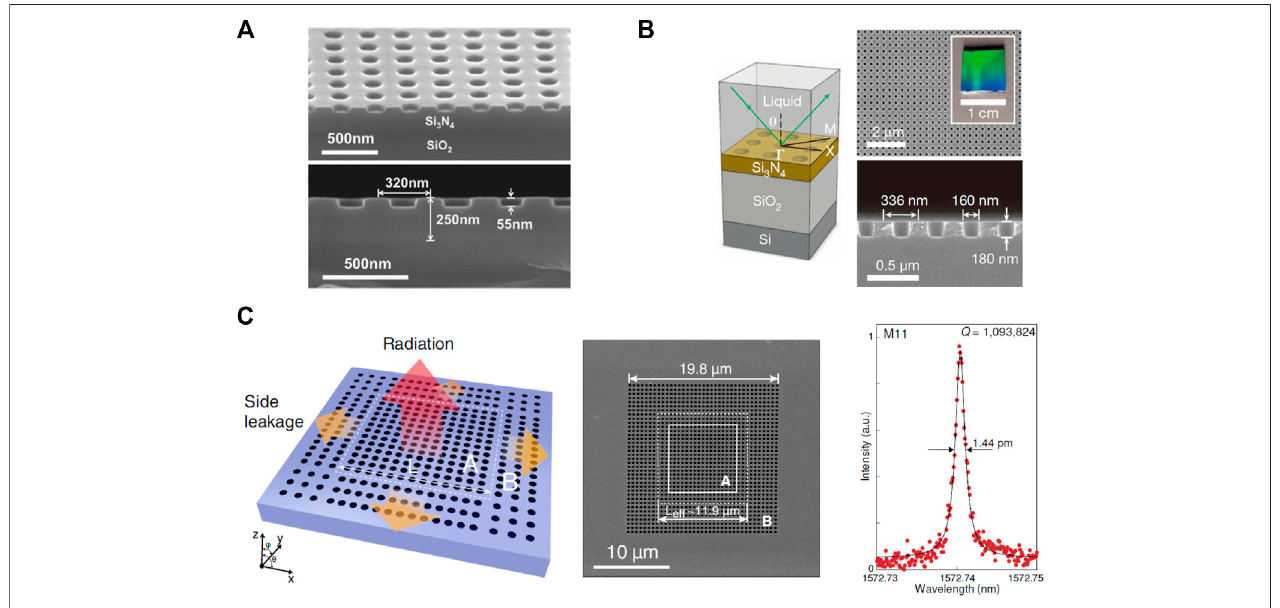
FIGURE 3 | (A) Macroscopic photonic crystal [106] for observing symmetry-protected BICs, copyright American Physical Society. (B) The observation of symmetry-incompatible off- Γ BICs [17], copyright Springer Nature Ltd. (C) Miniaturized BICs [107], copyright Science China Press.